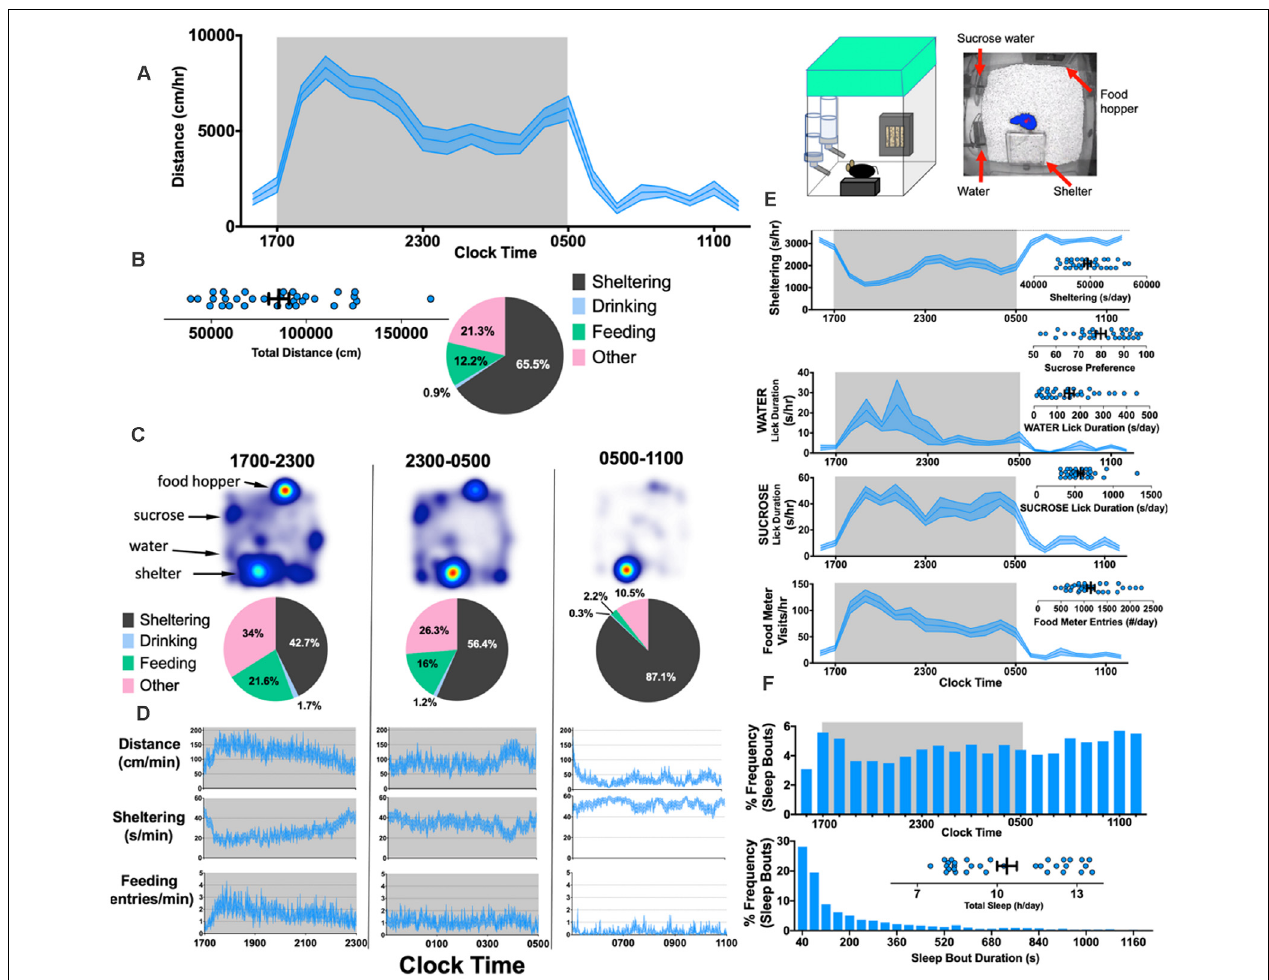
FIGURE 6 | Simultaneously measuring kinematic and neurovegetative function in PhenoTyper home cages. Right: Cartoon showing home-cage configuration with a screen capture from an aerial infrared camera showing mouse body contour (blue) and center point (red). (A) Horizontal distances accumulated hourly by 8-week old C57BL/6J mice ( n = 32, 16 female). (B) Total distances moved (per day), and the mean “time budget” calculated across this 21 h recording period. (C,D) Heat maps, time budgets and behavioral quantities depicted over 6 h long epochs. “Other” is defined as time spent not sheltering, drinking or feeding. (E) Average rates of sheltering, licking and feeding measured simultaneously with individual total values plotted in inset. (F) Percent frequency of (noninvasively derived) sleep bouts as a function of time of day (Top) and by duration of sleep bout (Bottom), with individual values obtained for total sleep (Inset). The mean + SEM is shown. The figure is adapted from Jankovic et al.